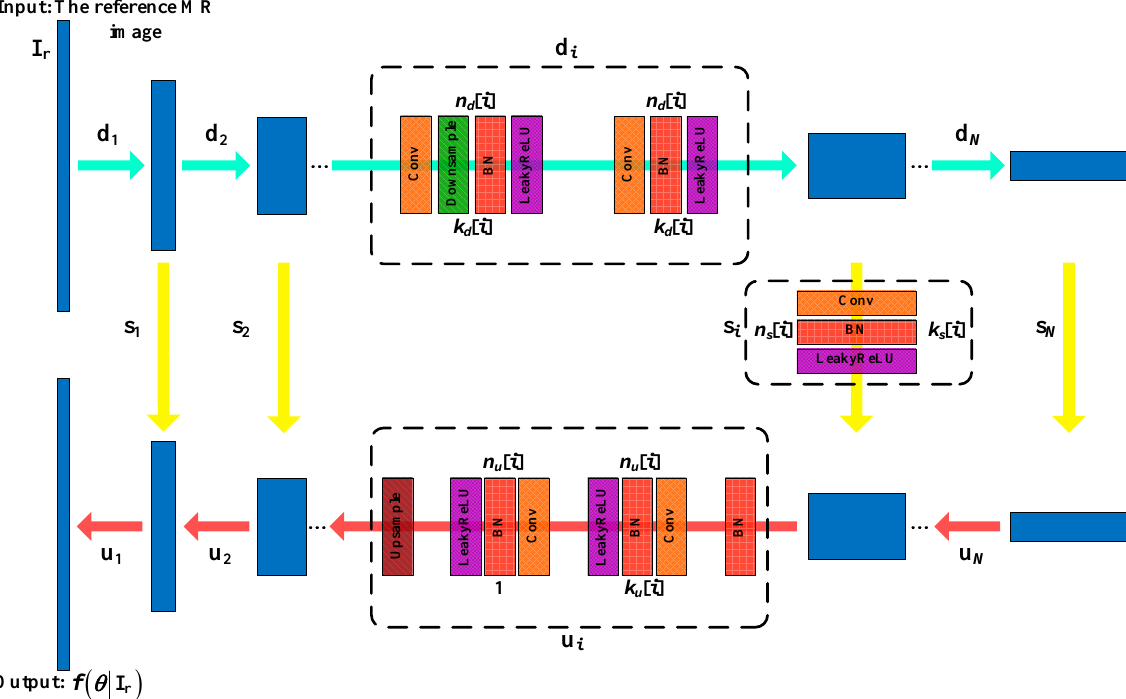
Figure 2. Network architecture [32] used in the proposed